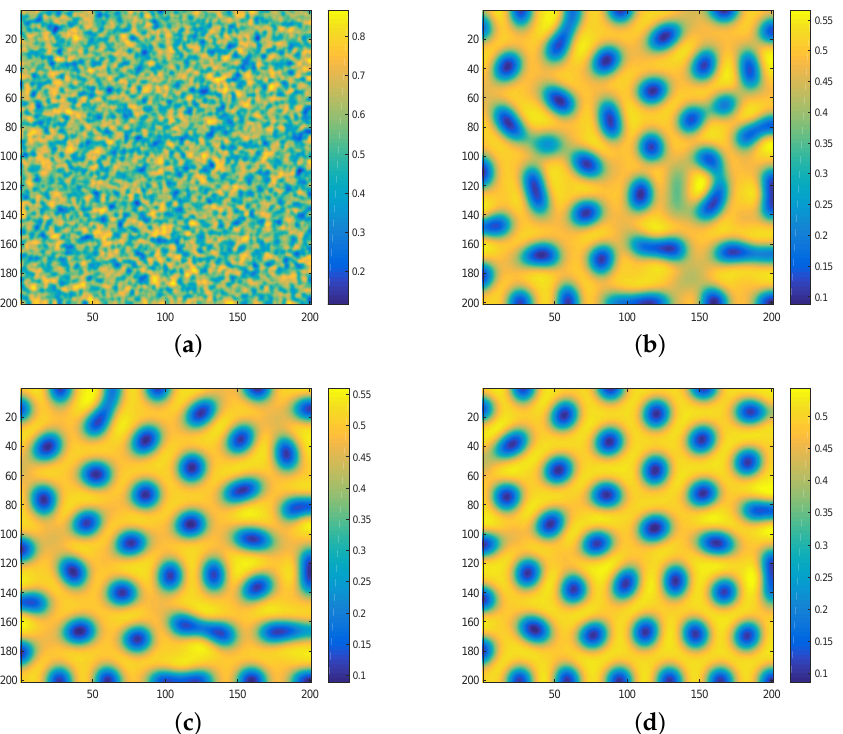
Figure 7. The patterns formation process of the prey population at ( a , c , d 12 , d 21 ) = ( 0.1,0.56,0,0 ) , the other parameters are fixed as in (36). Times: ( a ) t = 0, ( b ) t = 200, ( c ) t = 500, and ( d ) t = 1000.